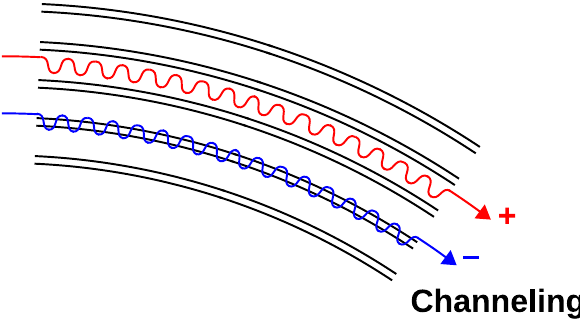
Fig. 2 Schematic illustration of channeling in a bent crystal formed by non-equidistantcrystalplanes(e.g.(111)planesofasiliconcrystal).The signs indicate schematic trajectories either for positively or negatively charged particles